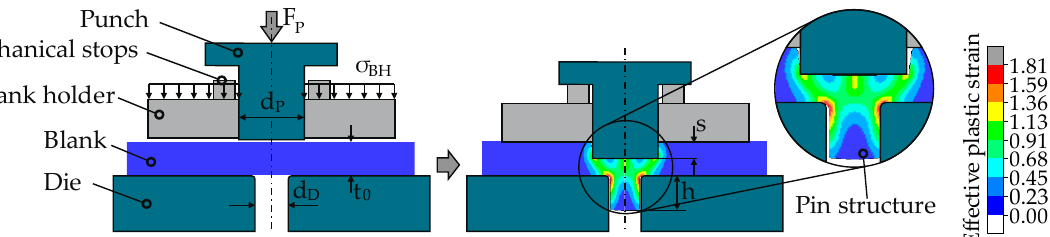
Figure 2. Illustration of the pin extrusion process and relevant process parameters.